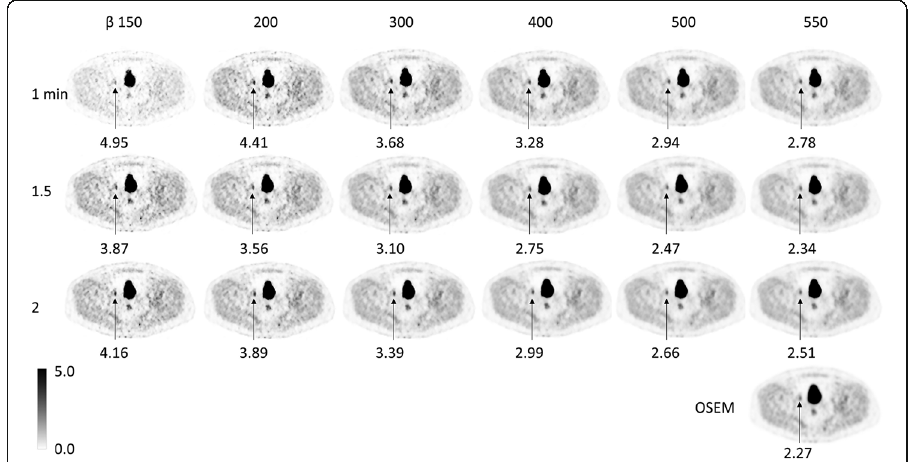
Fig. 5 Transversal images in the pelvis from one of the patients for the different reconstruction series. Arrow indicate the pathologic lymph node and the lesion SUV